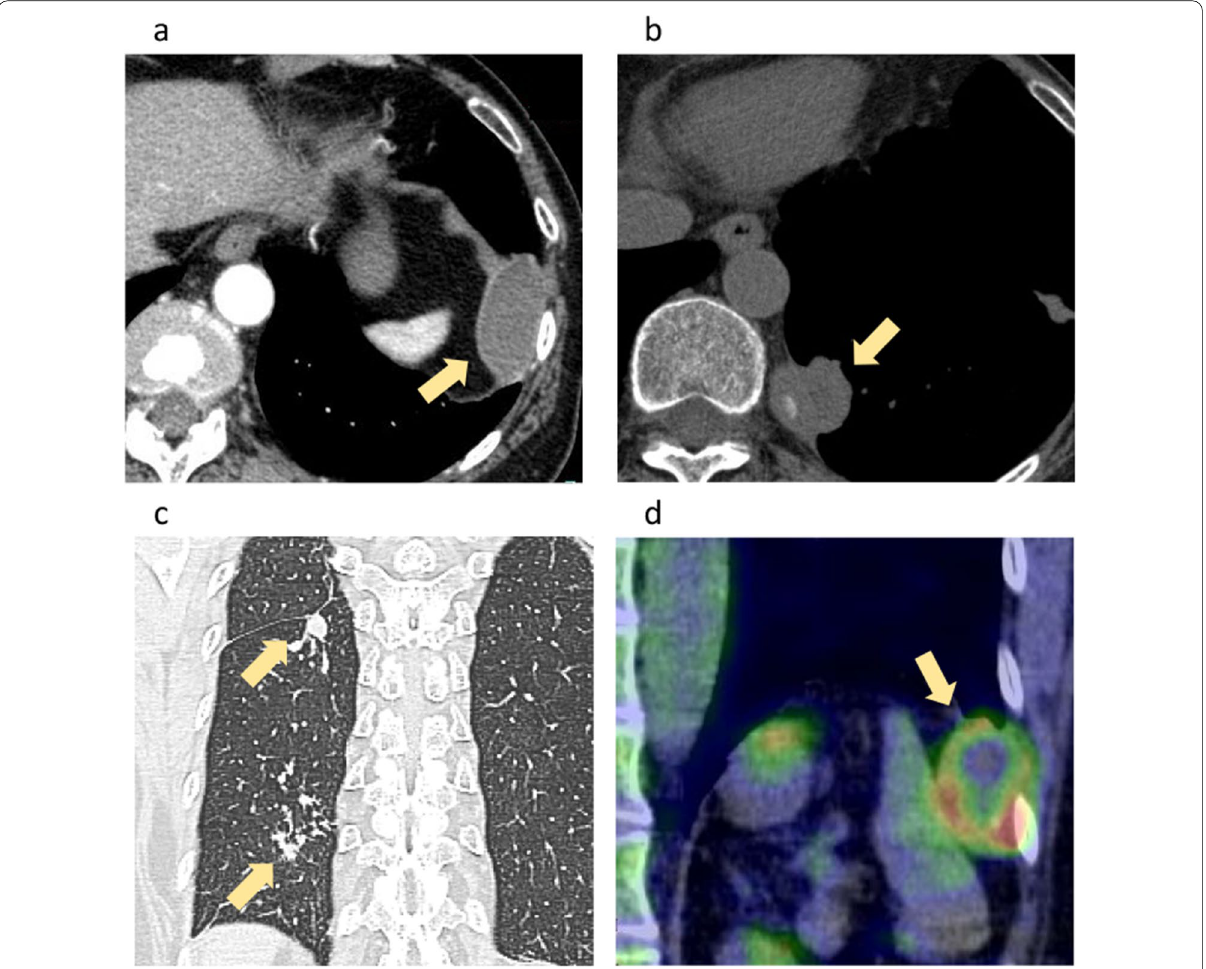
Fig. 1 CT and PET–CT. High-resolution lung CT images showed ( a ) a cystic lesion in the left diaphragm, b focal thickening of the posterior mediastinal pleura with calcification, and c multiple small nodules in both lung fields. d PET–CT (coronal view) showed increased uptake